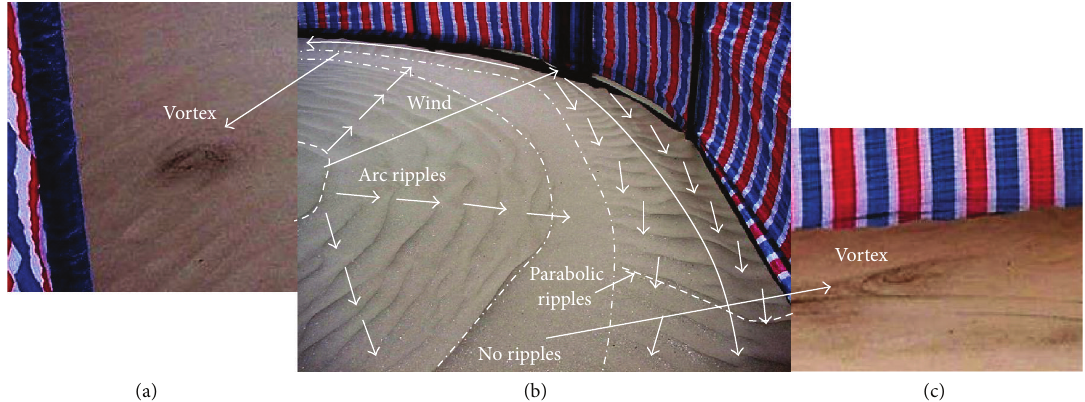
Figure 6: Field wind tunnel tests with semicircular obstacle. (a) a little whirlwind at left side; (b) different types of sand ripple area; (c) a little whirlwind at right side.